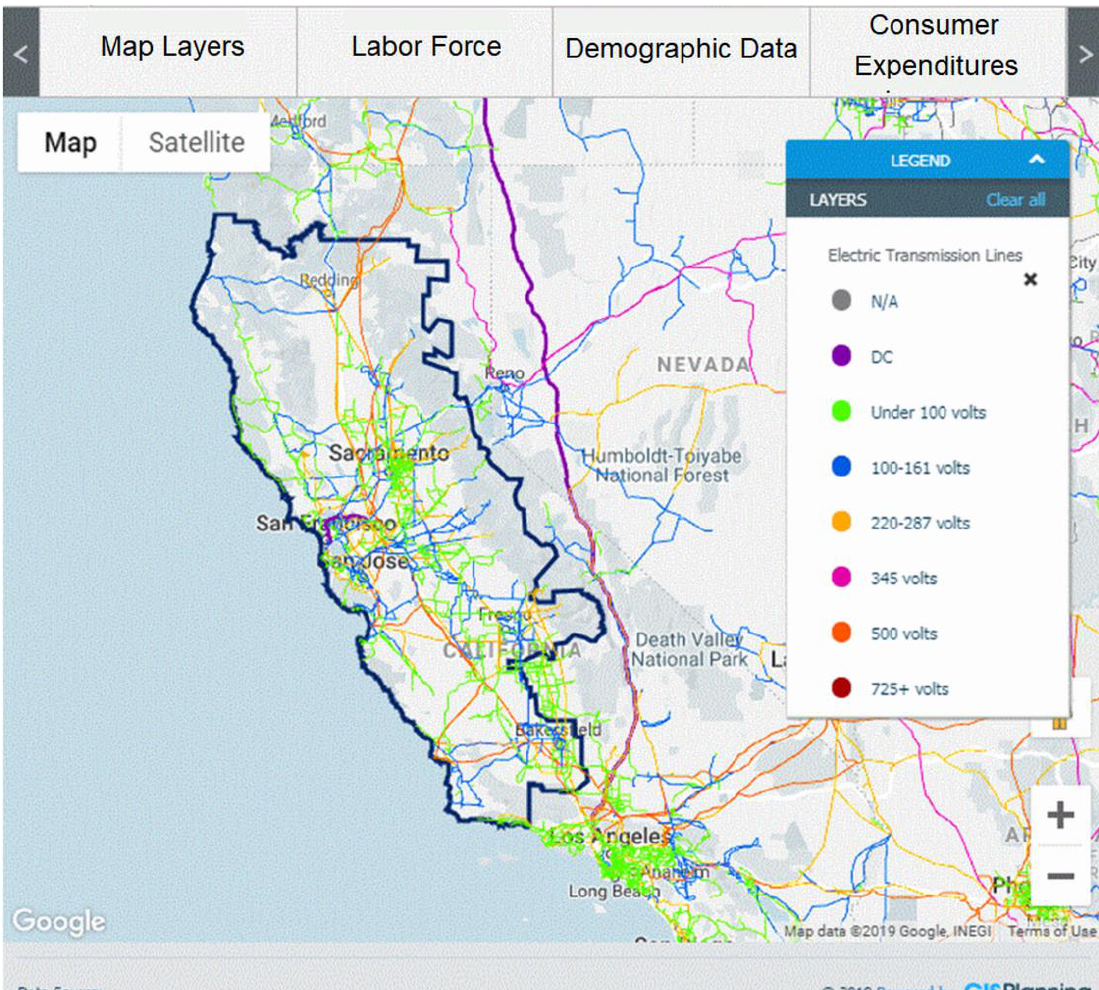
Figure 1. The current transmission network in California [14].